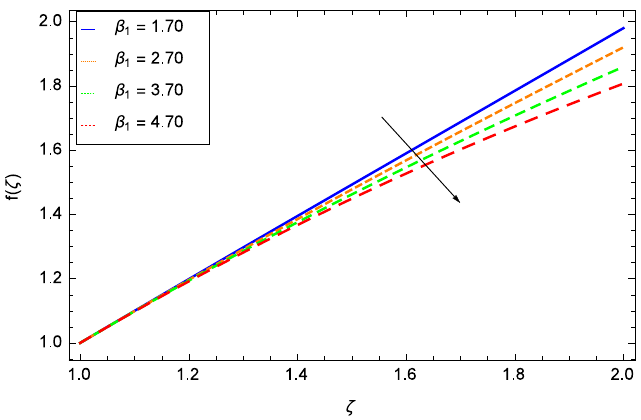
Figure 4. Non-dimensional velocity f ( ζ ) sketch for h = - 0.10, M = 0.10, Re = 0.70, φ = 0.04, Pr = 6.80 and various values of β 1 (CuO-H 2